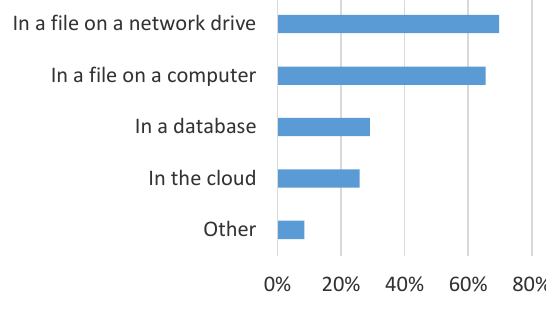
Figure 2: Preliminary results on the typical storage mechanisms for point clouds of the OGC survey regarding the current state of standards and best practices in the management of point cloud